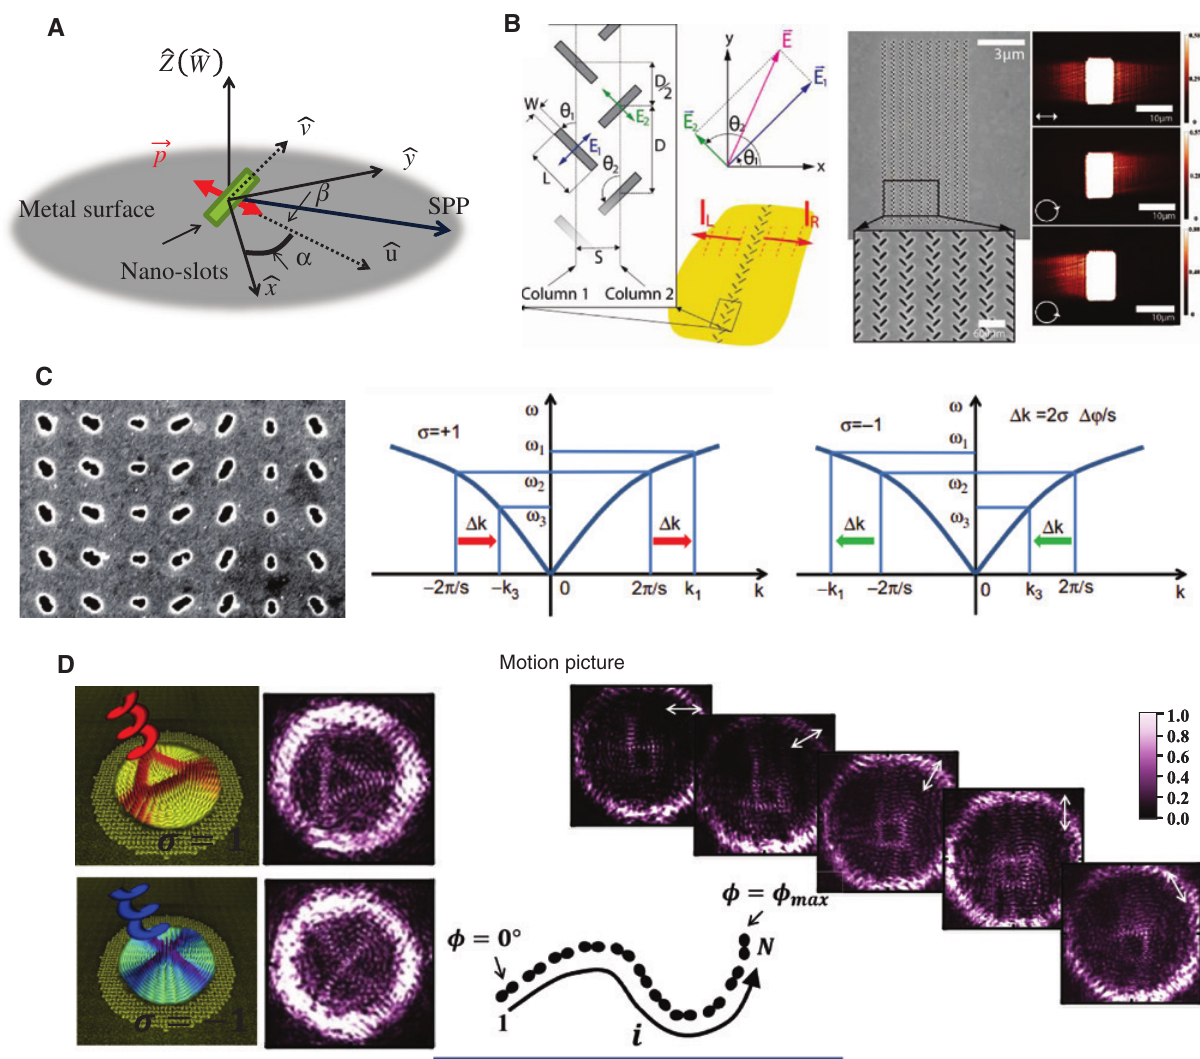
Figure 9: Spin-dependent trajectories enabled by nanoslots array. (A) Schematic diagram in generating surface plasmon by a dipole source on metal surface. (B and C) Unidirectional propagation achieved by nanoslots, where B (C) employs coupled (single) nanoslots in one unit cell. (B and C) Reprinted from Refs. [103, 104], respectively. (D) Scheme of flexible coherent control of plasmonic SHE. Left: Independent generation of local orbitals for the two incident spins. Right: Motion picture generated by rotating a linear incident polarization in writing a letter “b”. Reprinted from Ref.